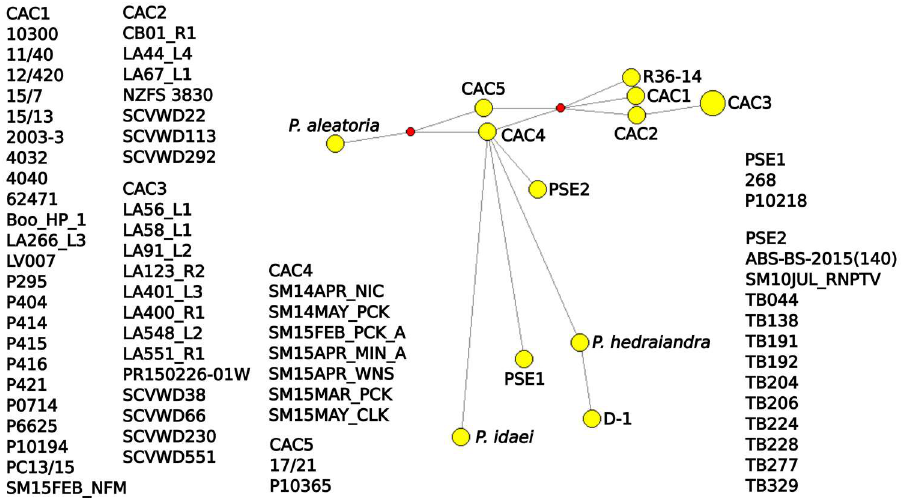
Figure 8. Median-joining network from ITS rDNA sequences of Phytophthora cactorum , P. pseudotsugae and other subclade 1a species. Accession information listed in Table S1. Figure created with Network 10 and annotated with InkScape. Yellow circles represent isolates or groups of isolates with identical sequences, and red diamonds represent unsampled intermediates.